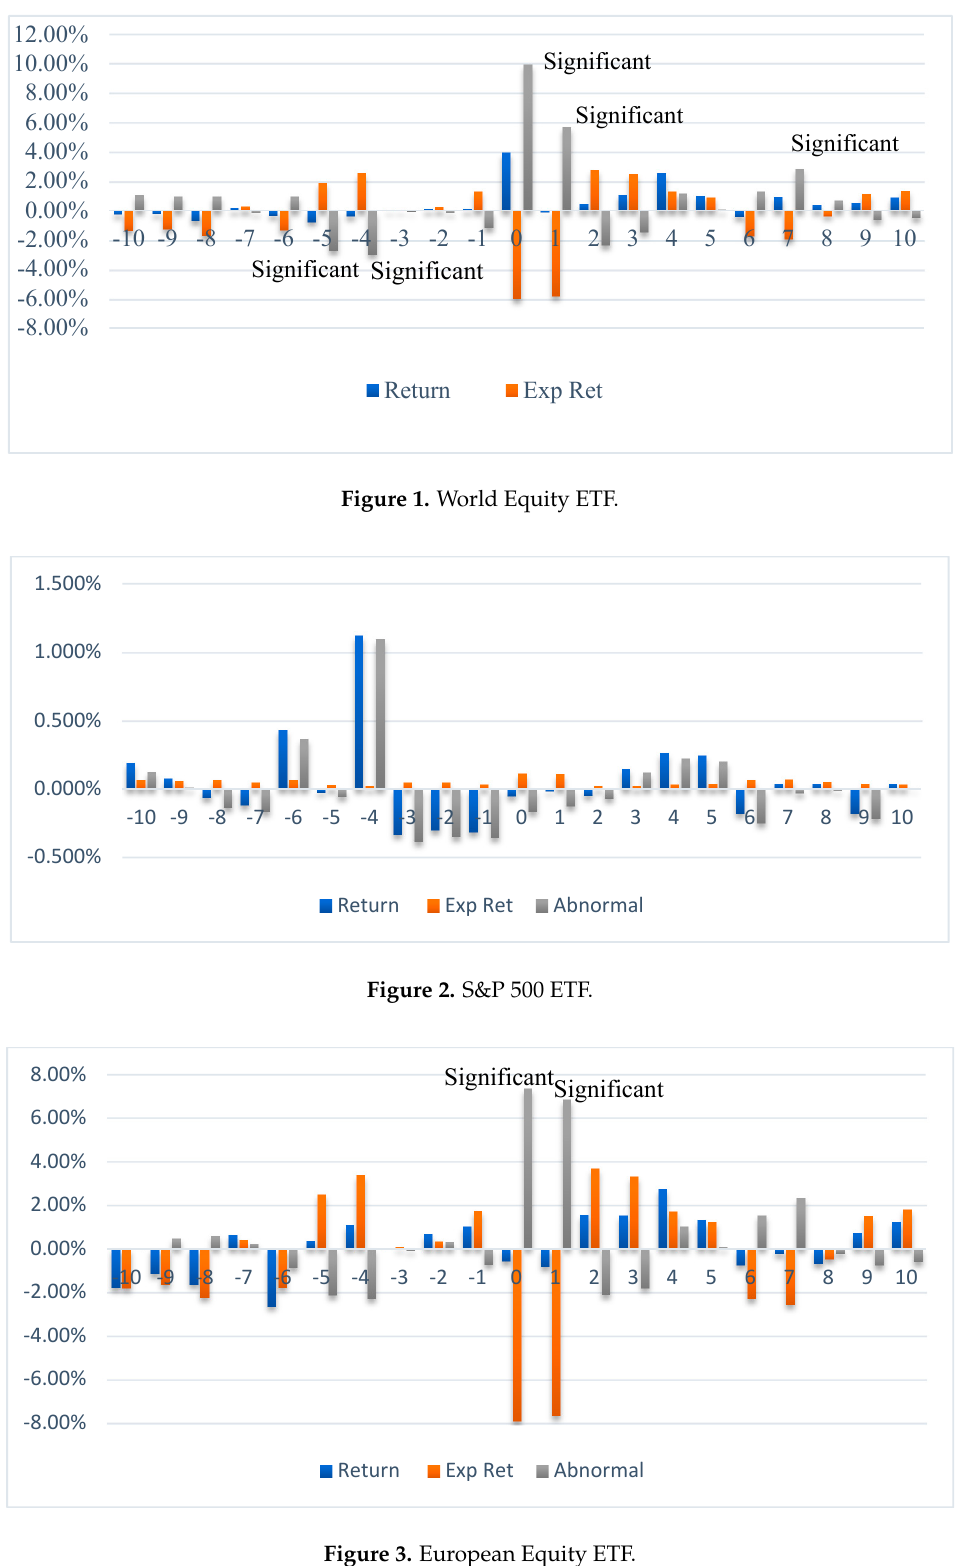
Figure 4. Emerging Equity ETF.